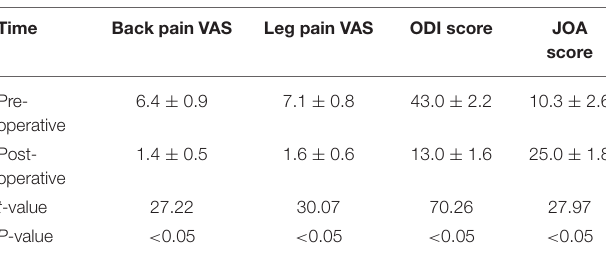
TABLE 1 | Comparison of pre-operative and 3 month post-operative back pain VAS, leg pain VAS, ODI, and JOA scores (average ± standard deviation).